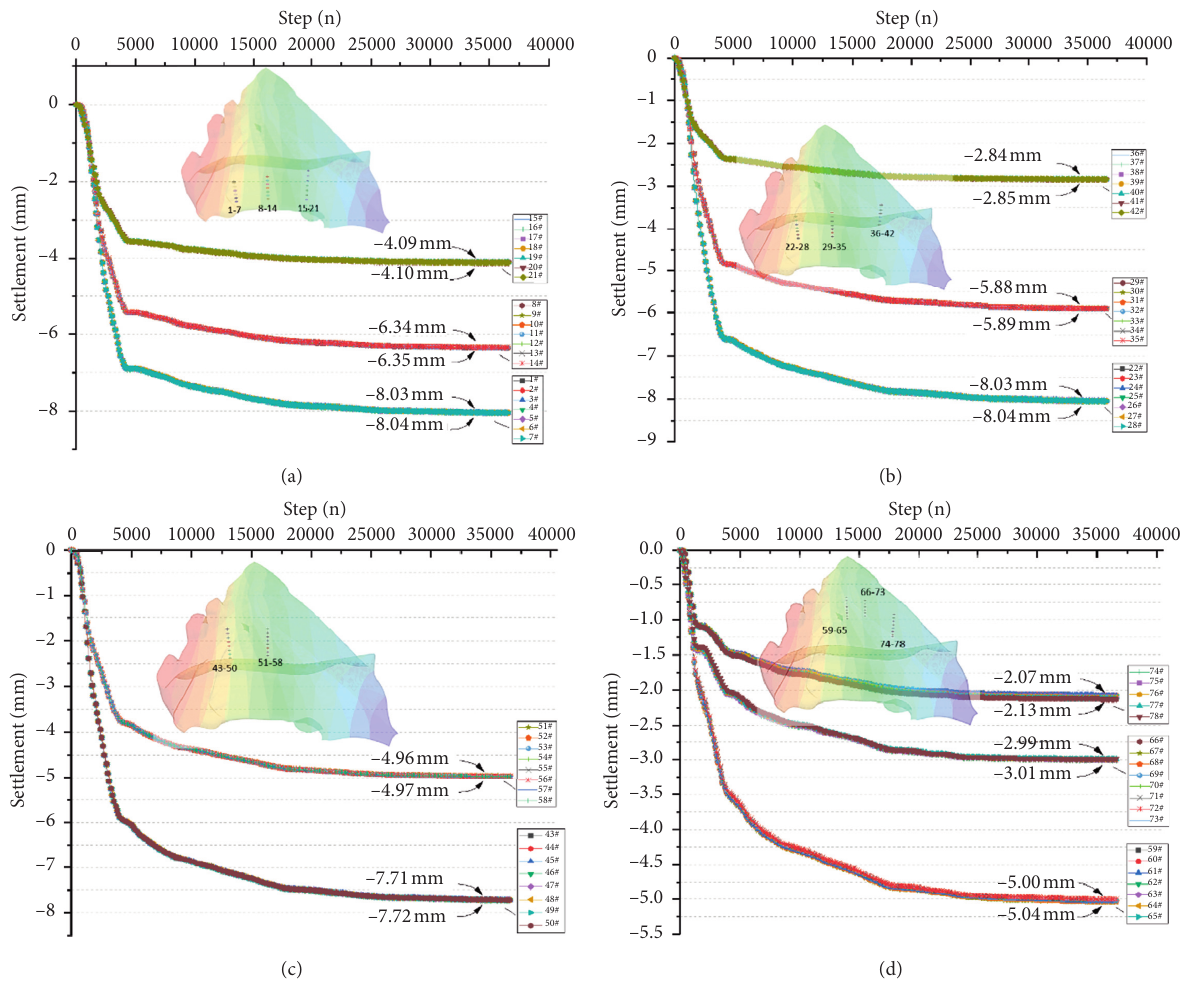
Figure 16: Monitoring curve of roof displacement monitoring points in Yuanjue Cave. (a) Displacement monitoring curve of measuring point (1–21#), (b) displacement monitoring curve of measuring point (22–42#), (c) sisplacement monitoring curve of measuring point (43–58#), and (d) displacement monitoring curve of measuring point